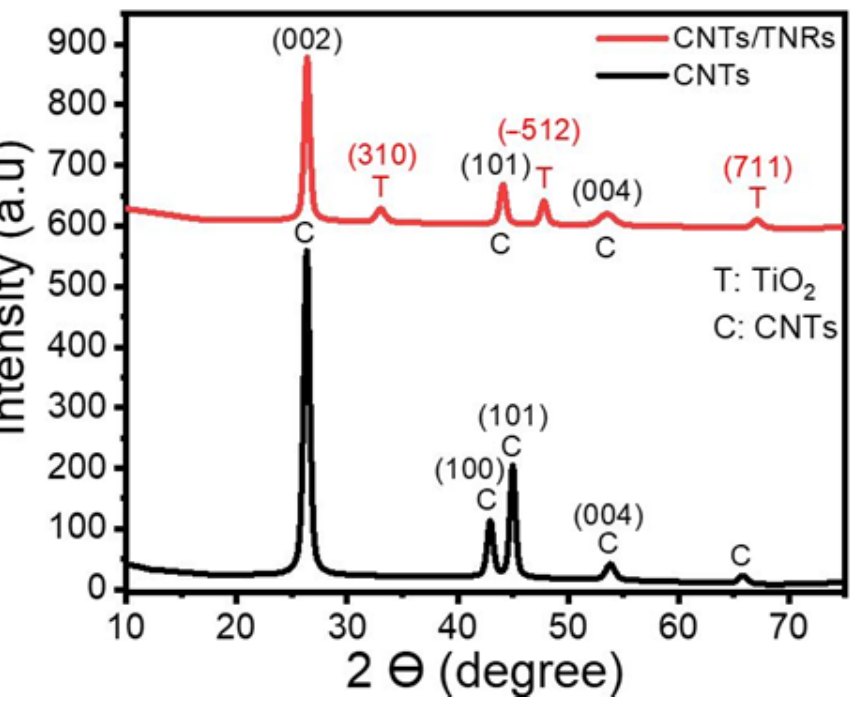
Figure 1. The XRD pattern of a TNR/CNT nanocomposite. The XRD pattern of TNRs/CNTs exhibited three unique CNT peaks at 2 θ = 26.34 ◦ , TiO 2 -B is associated with the peaks in the Figure 1 planes (310), ( − 512), and (711) at 33.0 ◦ , 47.76 ◦ , and 67.02 ◦